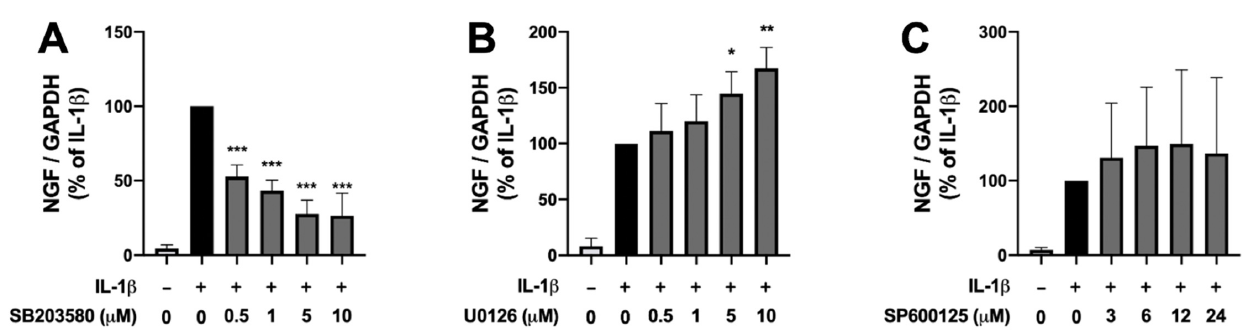
Figure 1. Involvement of various mitogen-activated protein kinase (MAPK) pathways in interleukin-1 β (IL-1 β )-induced nerve growth factor (NGF) expression in human intervertebral disc (IVD) cells. Confluent human IVD cells were serum starved, preincubated with the indicated concentrations of a p38 inhibitor (SB203580) ( A ), a MEK1/2 (upstream of extracellular signal-regulated kinase [ERK]) inhibitor (U0126) ( B ), or a c-Jun N-terminal kinase (JNK) inhibitor (SP600125) ( C ) for 30 min, and then stimulated with IL-1 β (10 ng/mL) for 24 h. The relative expression levels of NGF were quantified by real-time PCR. Results are expressed as the mean ± SD ( n = 4 individuals) after normalization to GAPDH, and expressed as a relative value to that of IL-1 β alone. * p < 0.05, ** p < 0.01, and *** p < 0.001 vs. IL-1 β alone.